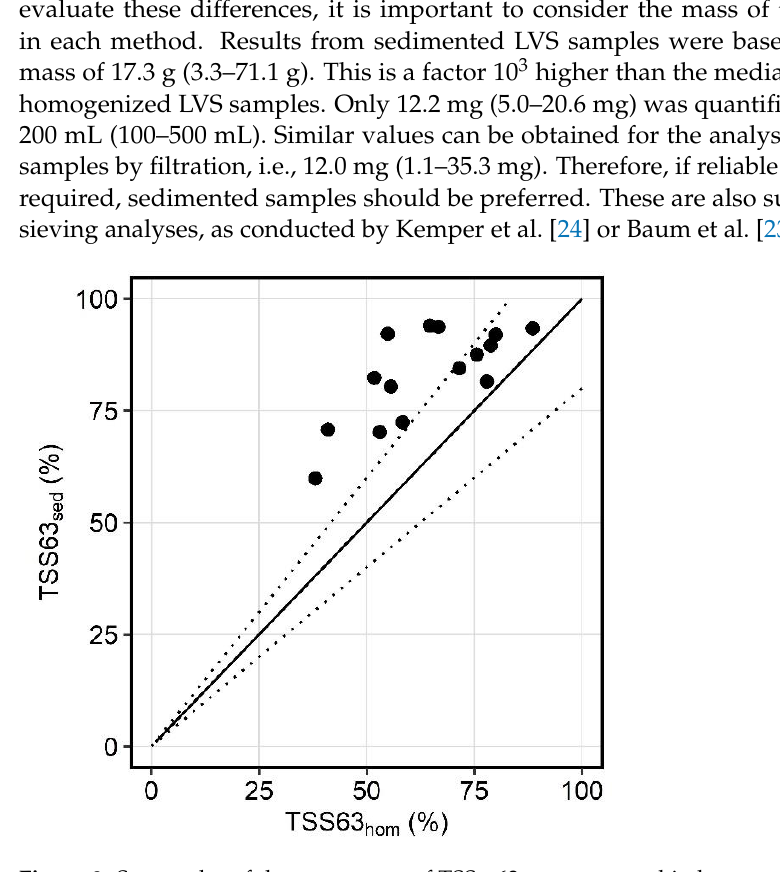
Figure 8. Scatterplot of the percentage of TSS <63 µ m measured in homogenized (TSS63 hom ) and sedimented (TSS63 sed ) large-volume samplers samples. Dotted lines show 20% deviation.